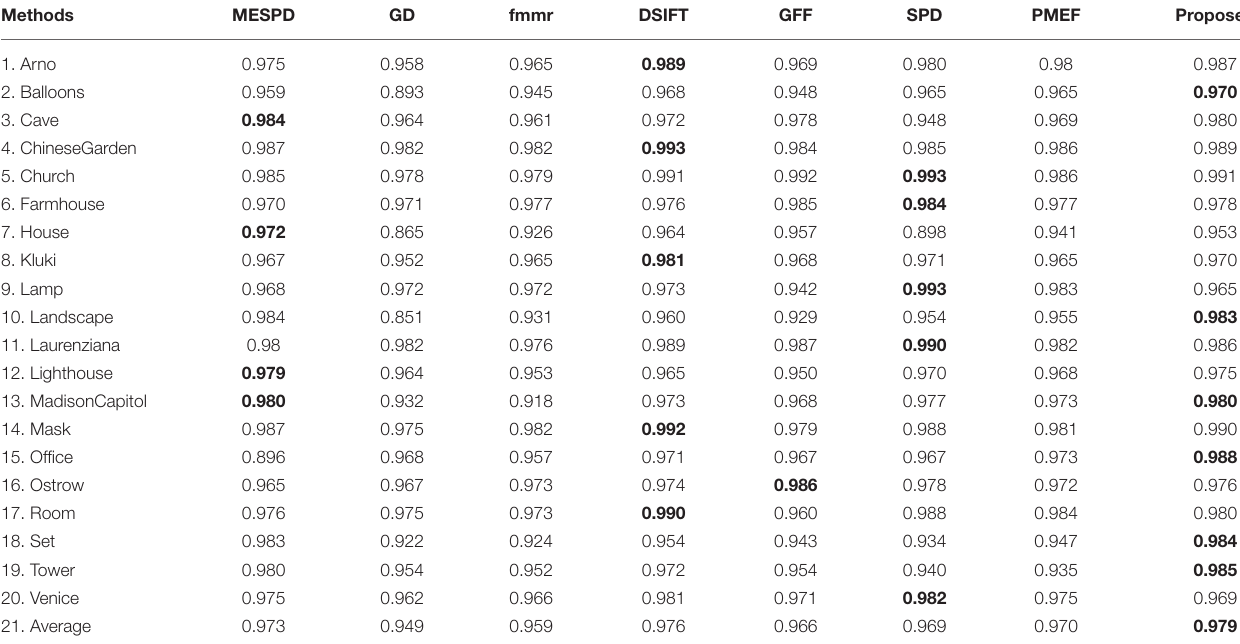
TABLE 2 | Comparison of MEF-SSIM indexes of seven fusion methods.